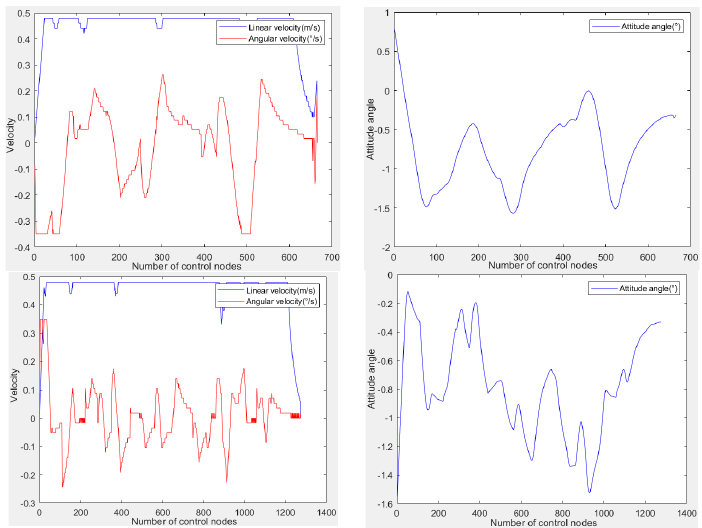
Figure 11. Simulated vehicle status diagram. Table 1. Comparison of experimental results of the two algorithms.